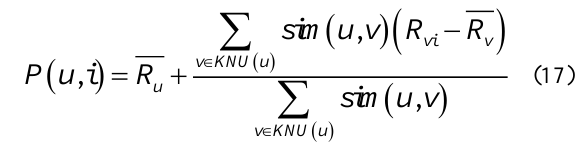
Table 1. Sample data